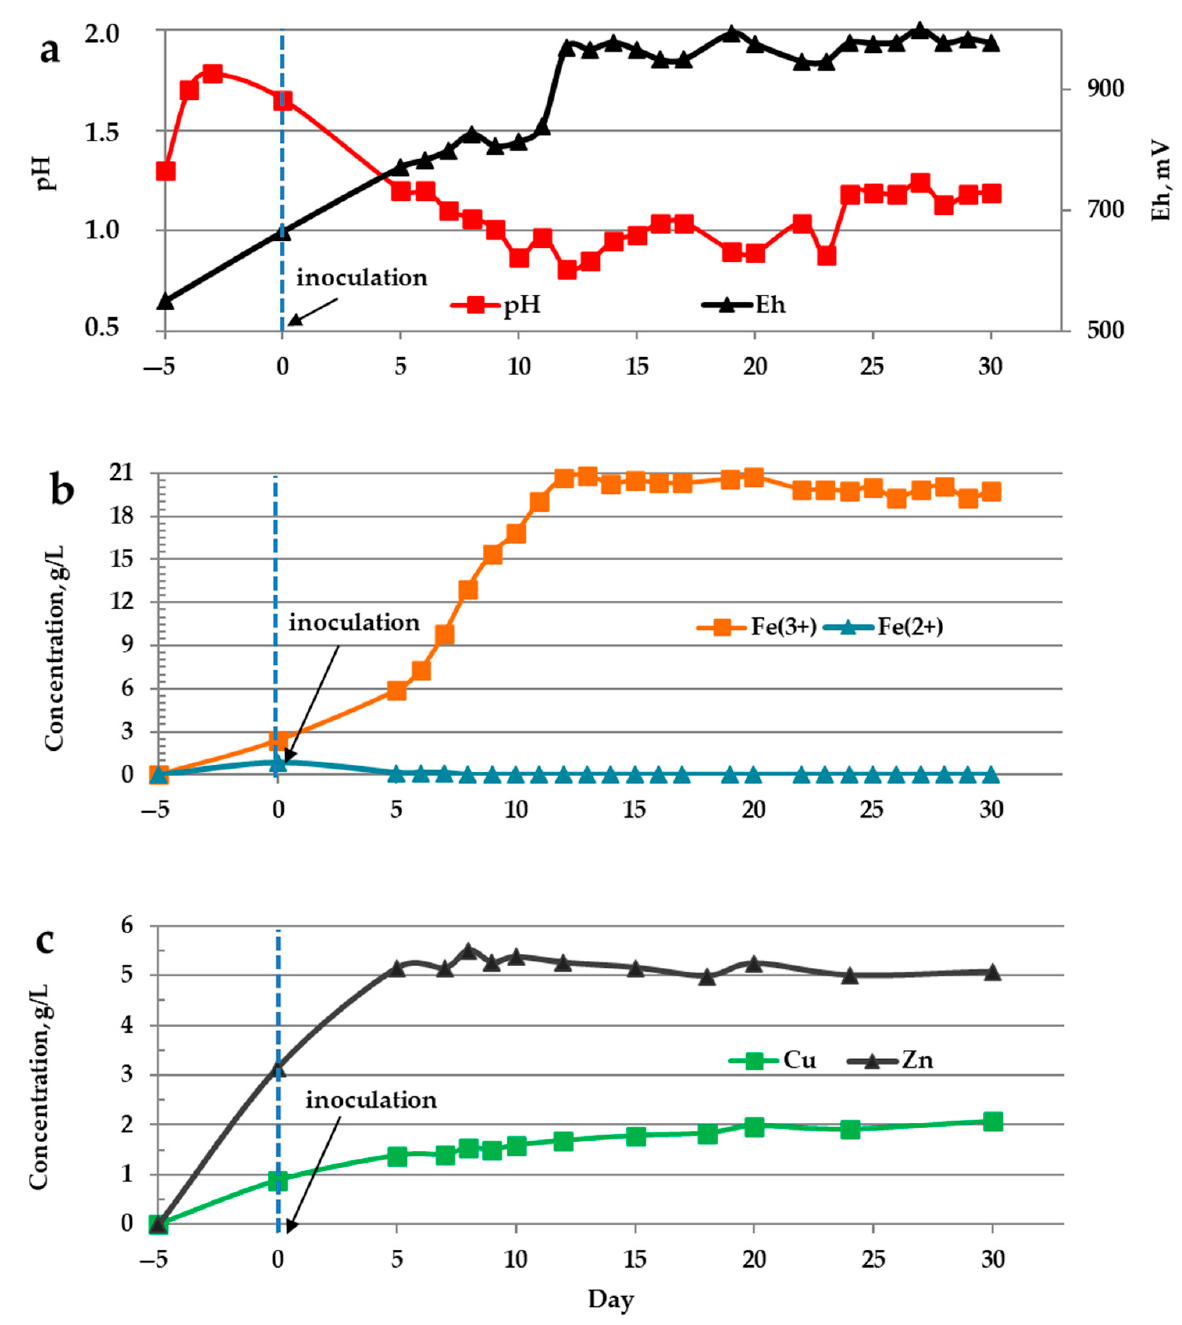
Figure 2. Changes in the liquid phase parameters during the bioleaching of the concentrate in batch mode: pH and Eh (mV) values ( a ), concentrations of Fe 3+ and Fe 2+ ions (g/L) ( b ), concentrations of copper and zinc (g/L) ( c ).